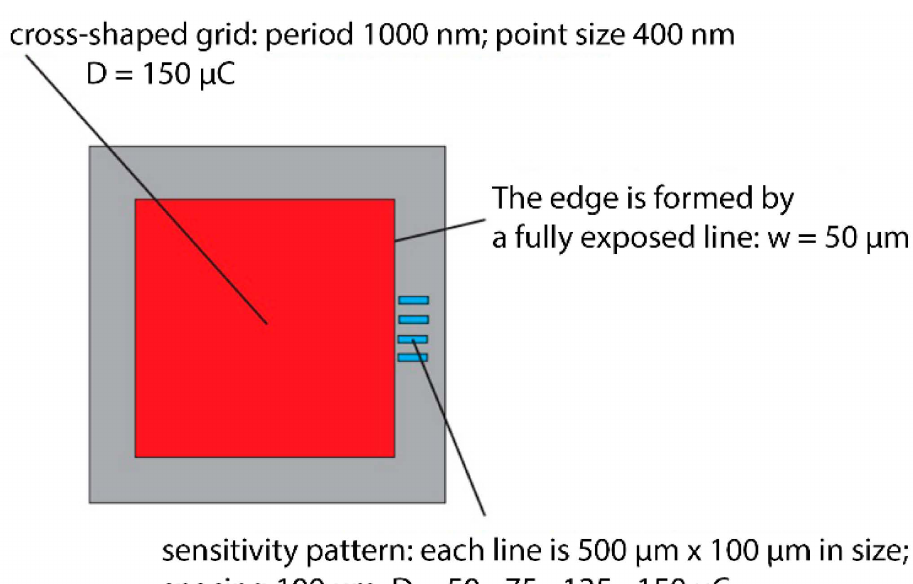
Figure 8. Main mask motif for the desired structure. Adapted from [15] with kind permission of Brno University of